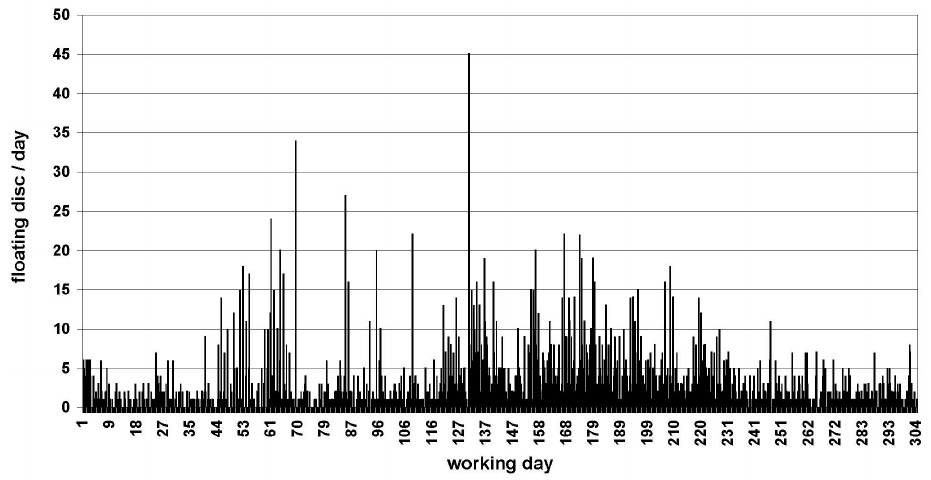
Figure 3. Seasonal distribution of “floating disc” signals. Working day 1 = January 2 nd ; working day 310 = December 31 st (6 working days/week).